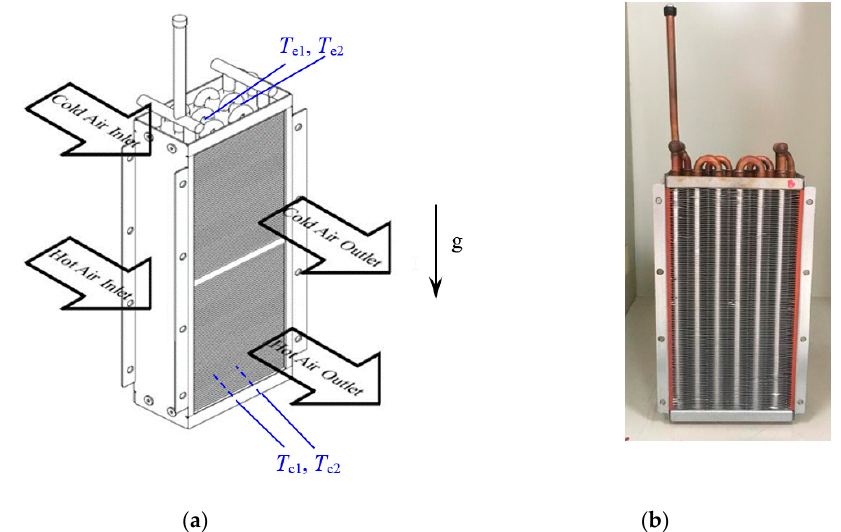
Figure 3. The pulsating heat pipe heat exchanger in this study. ( a ) The schematic diagram, and ( b ) the actual one.